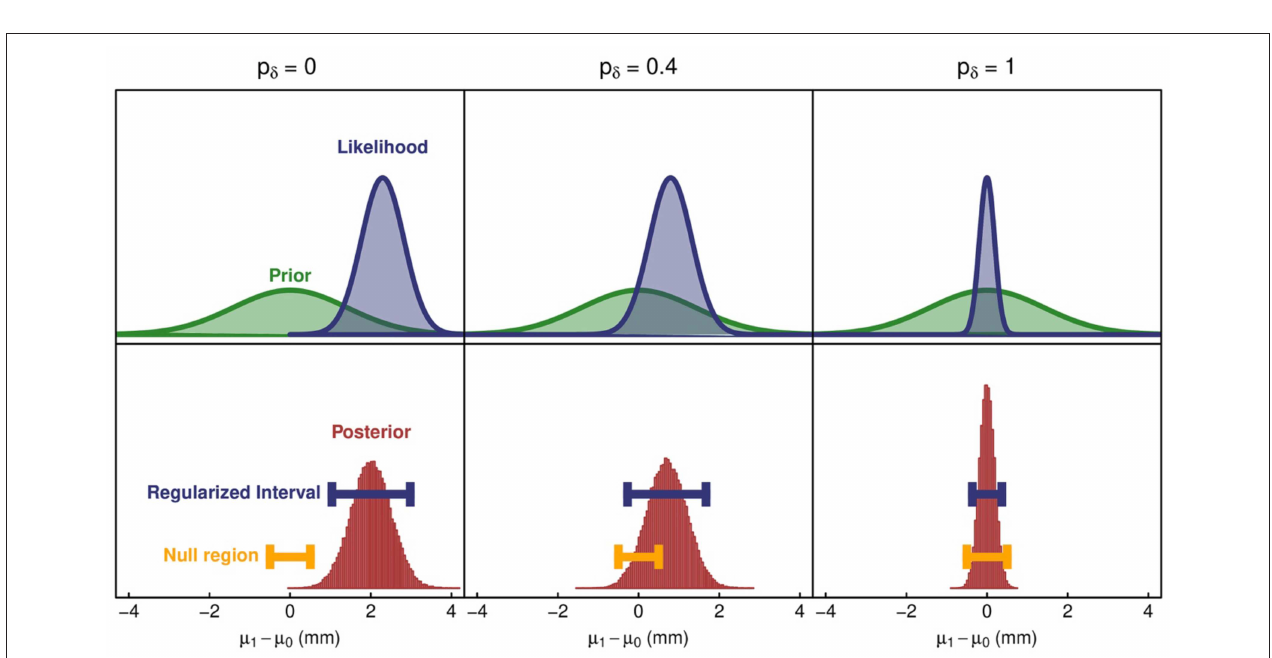
FIGURE 4 | A demonstration of three possible study results in the context of the horned lizard data. The left column shows an interval estimate that does not overlap with the null region, resulting in a second-generation p-value of 0. The middle column shows an interval estimate that straddles the null region, resulting in a second-generation p-value of 0.4. The right column shows an interval estimate that falls entirely within the null region, so the second-generation p-value is 1. The left column results from the unaltered data; whereas data for the middle and right column have been altered for demonstration purposes.